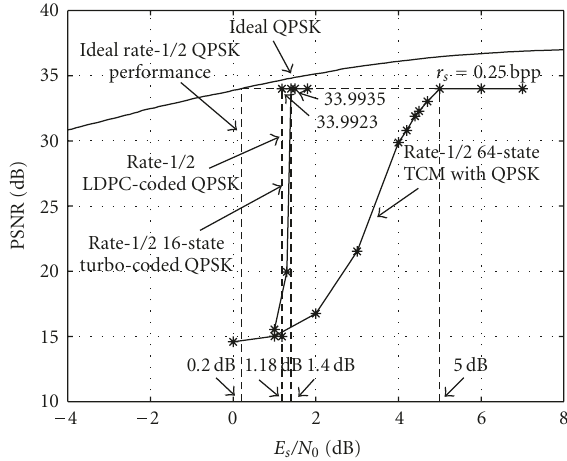
Figure 8: PSNR versus E s /N 0 performance of using a rate-1/2 512 Lena LDPC-coded QPSK for transmitting the SPIHT compressed 512 (cid:0)